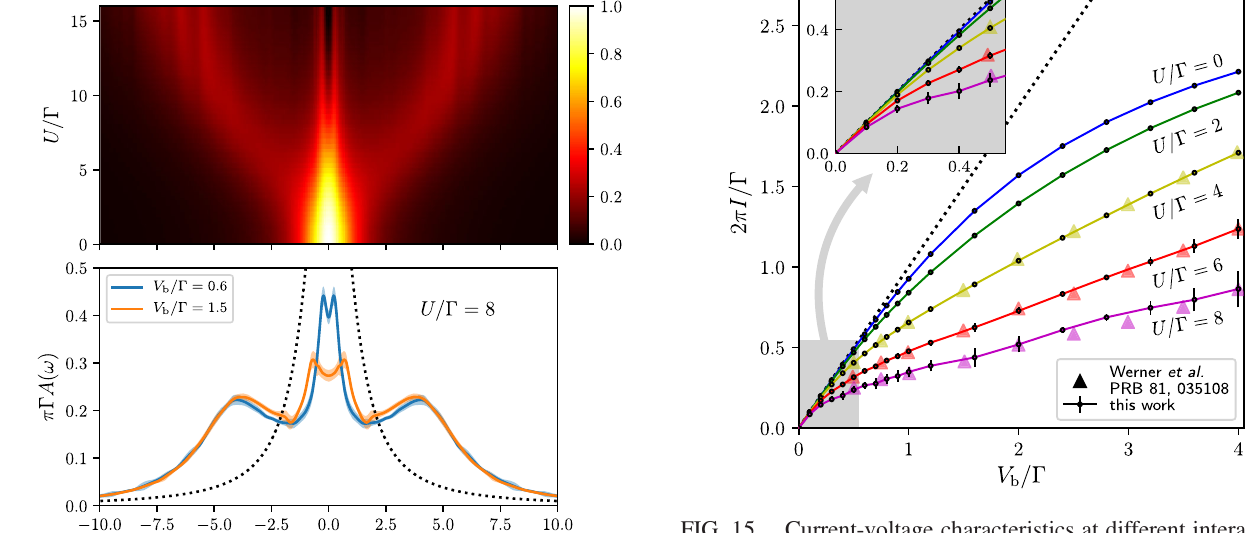
FIG. 15. Current-voltage characteristics at different interaction 0 . Perturbation series for the strengths in the symmetric case ϵ d ¼ current are computed using the Landauer formula Eq. (7) and bias.FIG. 14. Out-of-equilibrium spectral functions of the impurity then resummed. The results are consistent with a weak-coupling with the same parameters as in Fig. 13, except for temperature quantum Monte Carlo calculation from Werner et al. [31] T ¼ Γ = 50 . Top: Color plot of the spectral density as a function of (triangles) but extends further down in ω and U for a voltage bias V 0 . 6 Γ . Bottom: Spectral density at b ¼ 0 . 6 Γ (blue line) and V 1 . 5 Γ (orange U ¼ 8 Γ for a bias V b ¼ b ¼ line). Error bars are shown as shaded areas. The dotted line shows the noninteracting density. No Bayesian inference is used. The integration time is 20 = Γ .